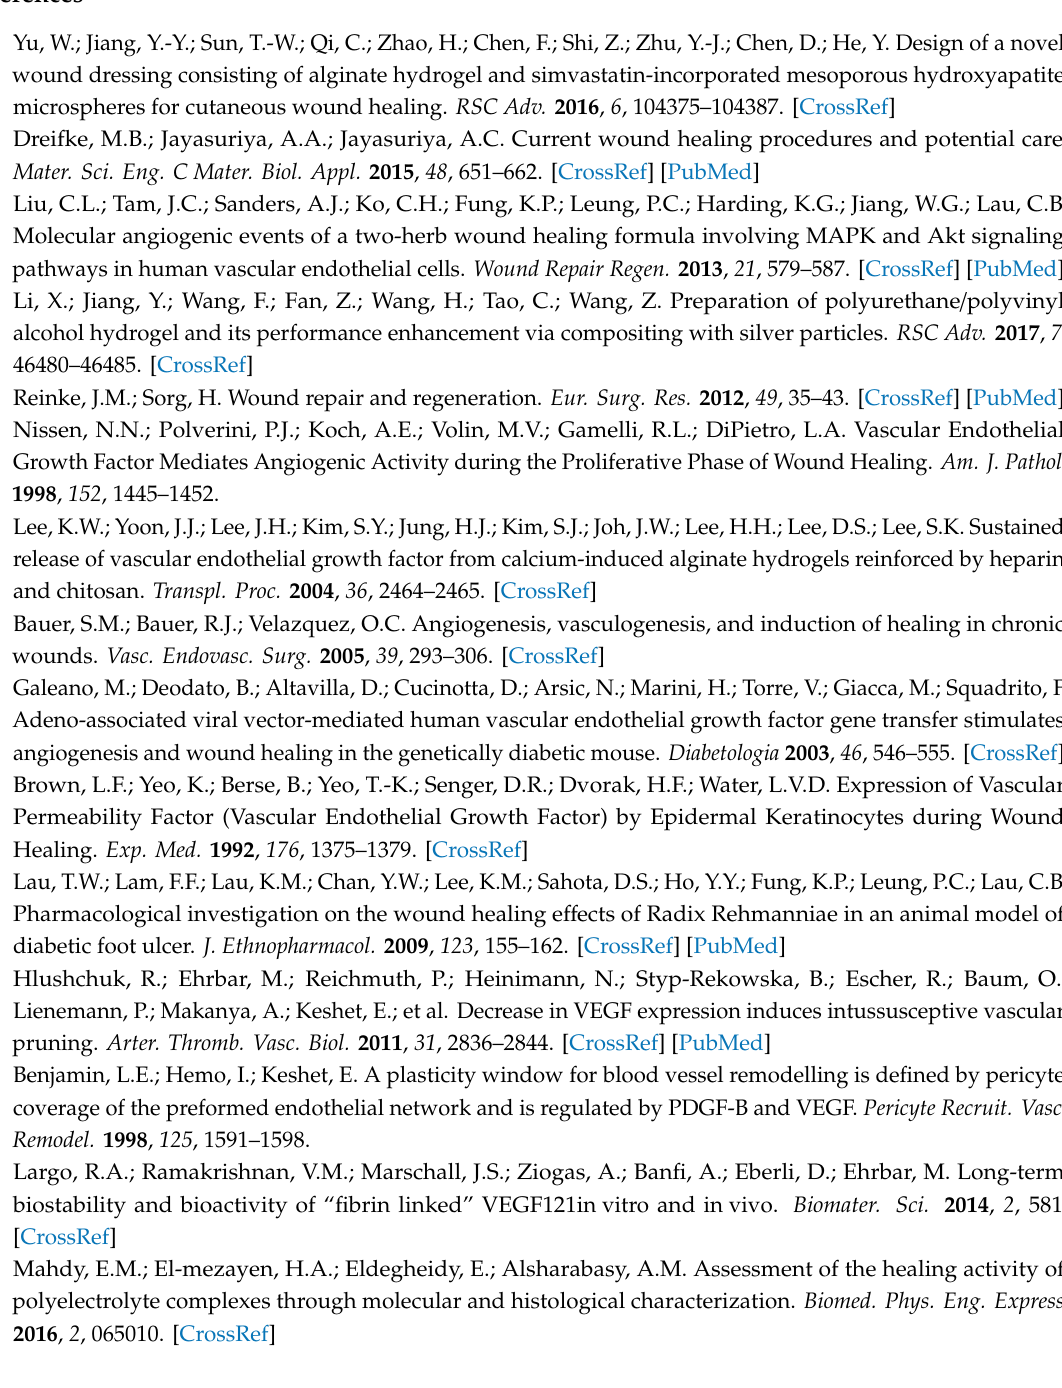
Figure S1: The e ff ect of the sol-gel transition behavior with di ff erent temperature in IPN hydrogel, Figure S2: 2D Raman spectrum of PF127 / SA IPN